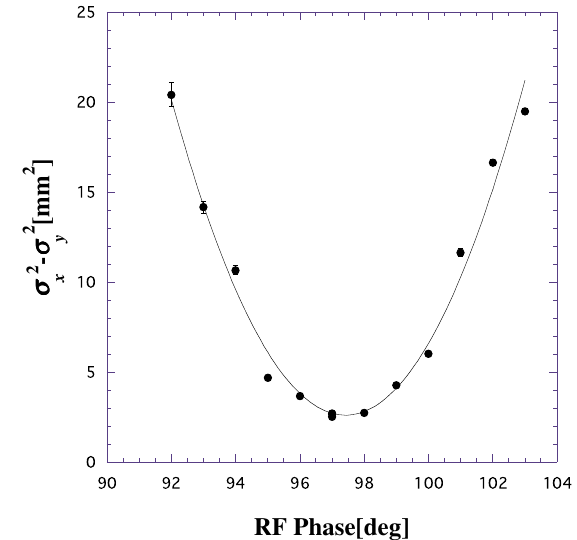
FIG. 4. (Color) Variations of the square difference of the trans- verse beamwidths (HWHM) for the 0.9-nC electron beam measured by the screen monitor. The solid line shows a curve with a quadric least-squares fitting